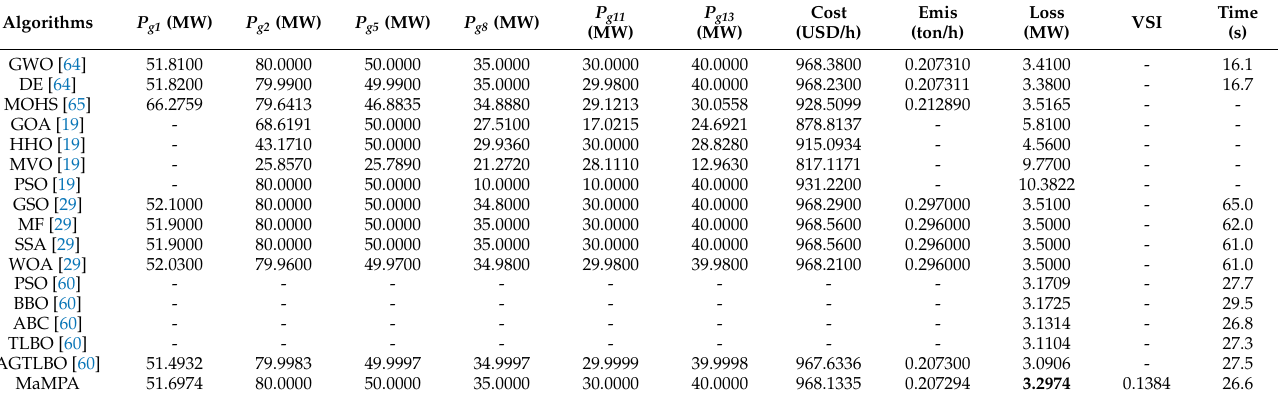
Table 4. Comparison results of case 3.